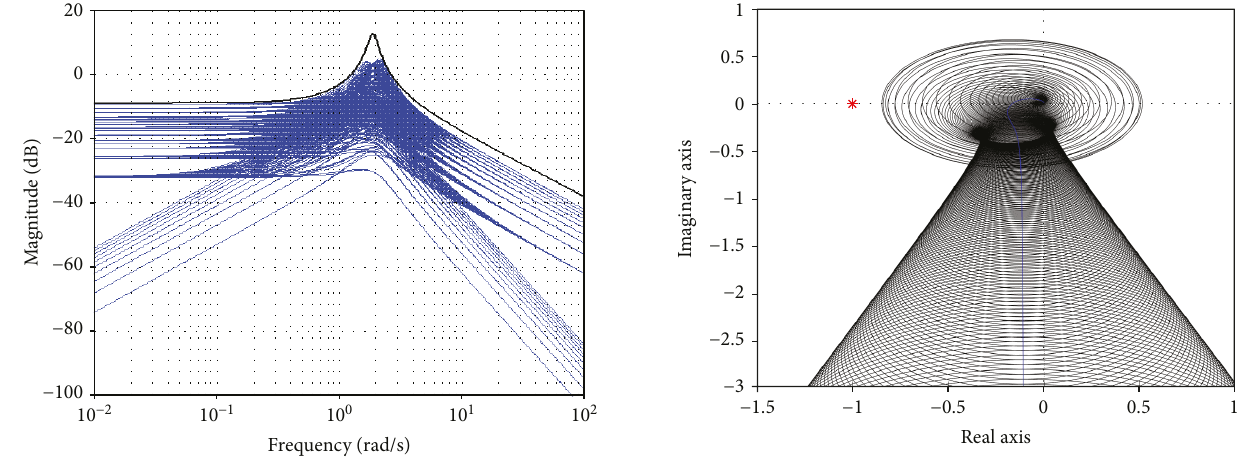
Figure 8: Envelope of Nyquist diagrams for FO plant family (27) and controller (22)